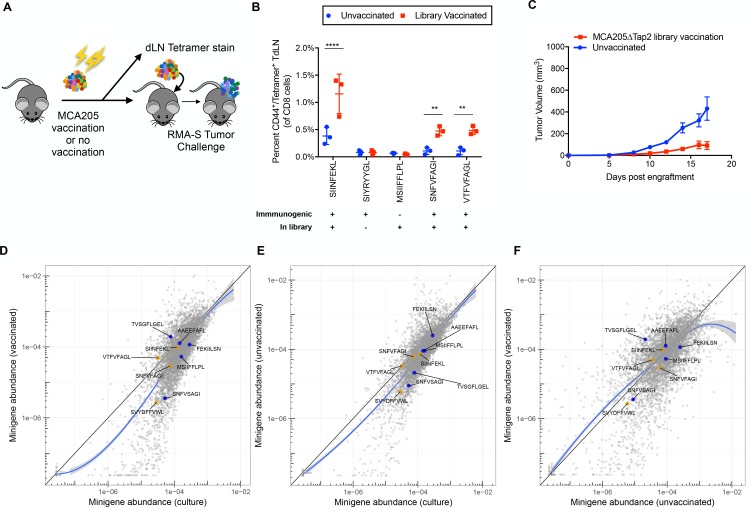
Vaccination of wild type mice with minigene library-expressing MCA205ΔTap2 cells leads to increased antigen-reactive T cells, but not increased immune surveillance(A) A schematic of the vaccinations performed on C57BL/6N mice. 107 irradiated MCA205ΔTap2 cells expressing wild type library peptides were injected subcutaneously every six days (for a total of three vaccinations) into eight animals. On day 18, three mice from each group were sacrificed for tetramer analysis. Draining lymph nodes and splenocytes were stained with H-2Kb peptide tetramers. At day 18, the remaining five mice were challenged with 5 × 106 RMA-S cells expressing the library. (B) Splenocytes and draining lymph node cells from vaccinated animals were stained for CD8, CD44, and H-2Kb/peptide tetramers. Five control peptides were evaluated: four found in the library and one peptide not found in the library. The frequency of CD44/tetramer positive CD8 cells is reported. (C) Growth curves of RMA/S library tumors in in vaccinated or unvaccinated mice. (D-F) Average abundance of each minigene in cultured cells before injection into mice (x-axis) compared to minigene abundance in tumors harvested from vaccinated (n = 4; y-axis) (D) or non-vaccinated (n = 5; y-axis) (E) mice. Each circle is a minigene. Orange circles indicate positive control (immunogenic) minigenes; blue circles indicate negative control (non-immunogenic) minigenes. (F) Direct comparison of minigene abundance in tumors grown in vaccinated and non-vaccinated animals. The straight black lines indicate x = y. LOESS (local best fit) lines are plotted in blue.10.7554/eLife.41090.012Figure 4—source data 1.Abundance of each minigene in the tumors of vaccinated and non-vaccinated animals.